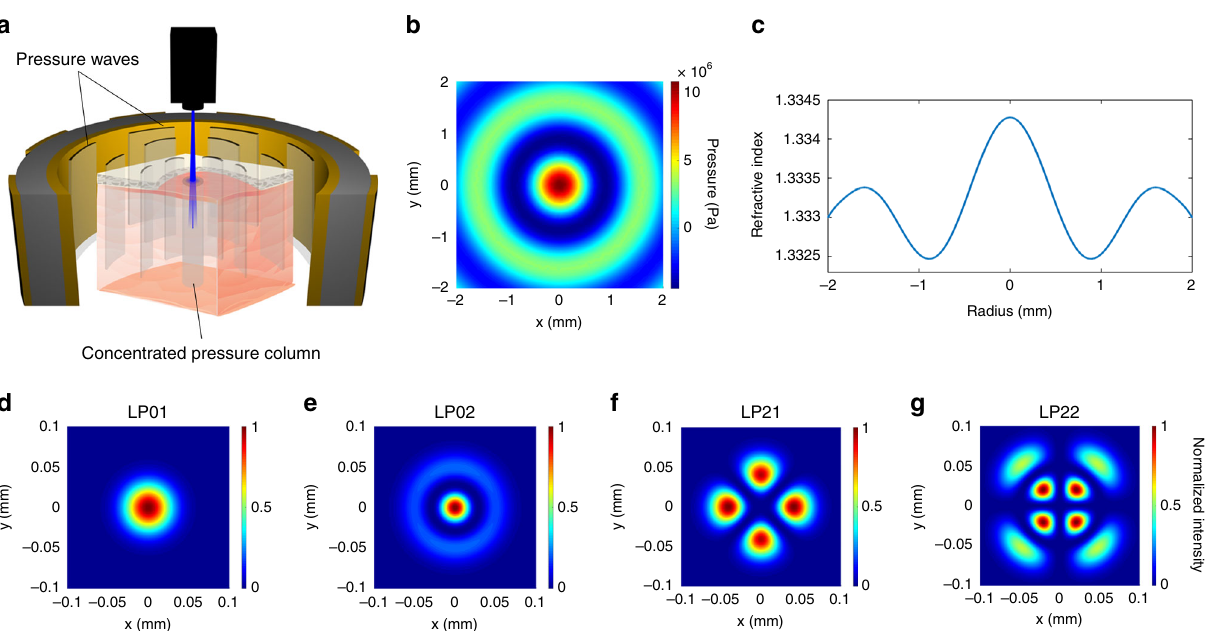
Fig. 1 Ultrasound sculpts virtual optical waveguides. a Schematic illustration of acousto-optic waveguide formation in a tissue. Pressure-induced density gradients in the tissue result in a refractive index contrast pro fi le that forms optical waveguides through which light can be con fi ned. b Standing wave ultrasonic resonant mode of an in fi nite cylindrical transducer (radius = 19 mm, thickness = 3 mm) in water medium (FEM simulation result). The pressure intensity is shown with the Pascal units. c Refractive index pro fi le calculated at a radial cross-section of the cylindrical waveguide. d – g The intensity pro fi les of a subset of con fi ned optical modes calculated using fi nite difference mode analysis. In each case, the intensity is normalized to its maximum